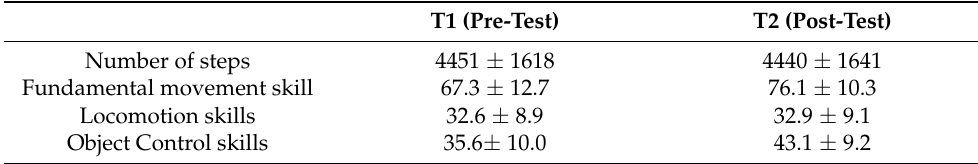
Table 1. List of descriptive statistics results ( n =